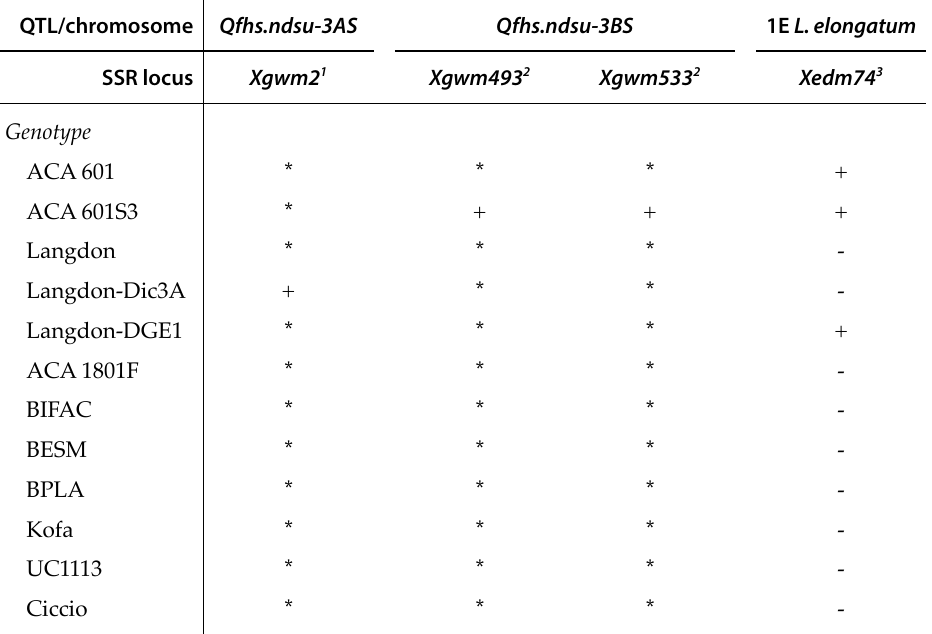
Table 1. Molecular screening of 12 wheat genotypes using SSR markers associated with Fusarium head blight resistance. For each tested genotype, (+) denotes presence of the allele linked to resistance, (*) presence of a different allele and (–) no amplification, at the indicated